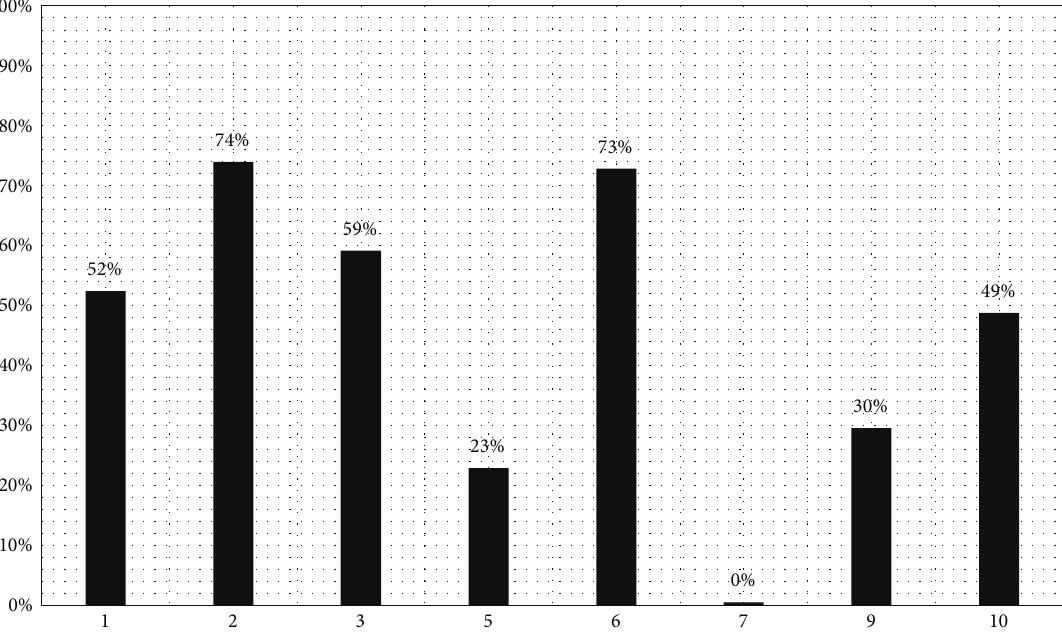
Figure 9: Jakob Nielsen ’ s interface